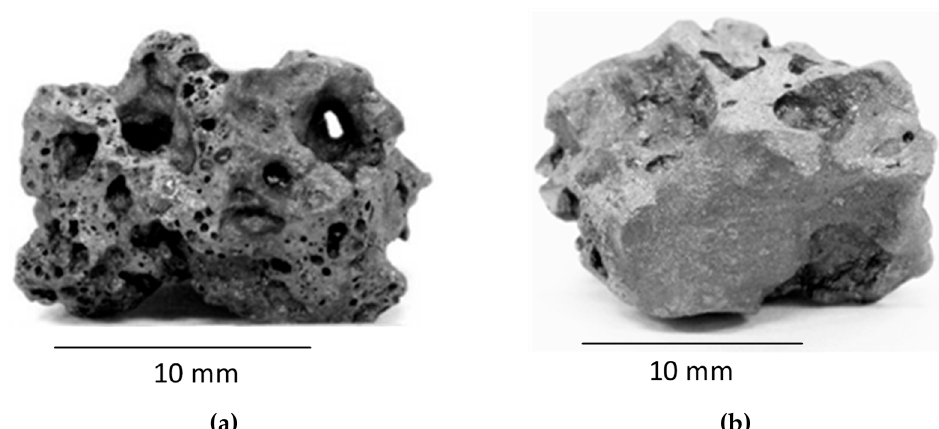
Figure 8. Optical photographs of "as received" iron ore sinters, ( a ) porous sinter lump, ( b ) dense sinter lump.